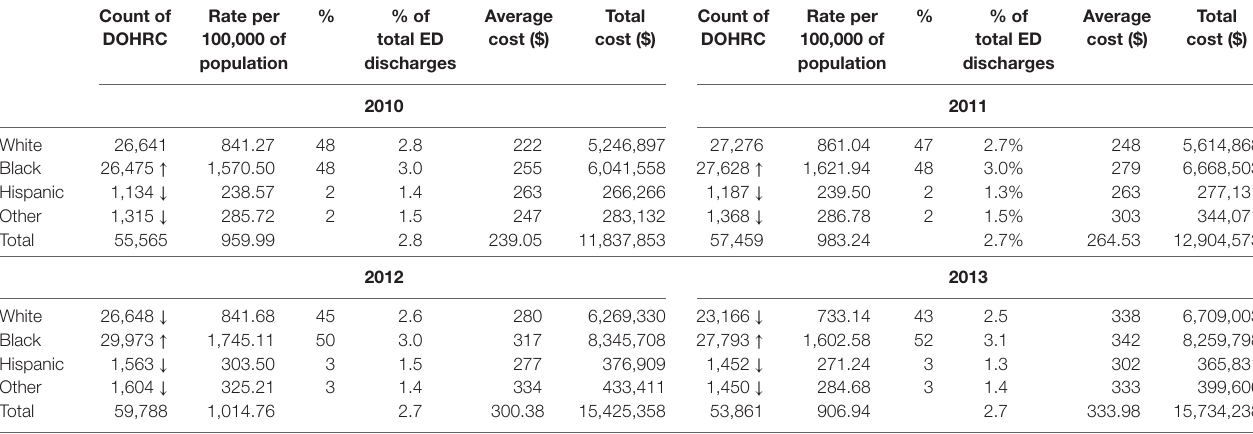
Table 1 | Maryland emergency department (ED) discharges for dental/oral health-related conditions (DOHRC) by race using 2010–2013 State Emergency Department Data (SEDD).